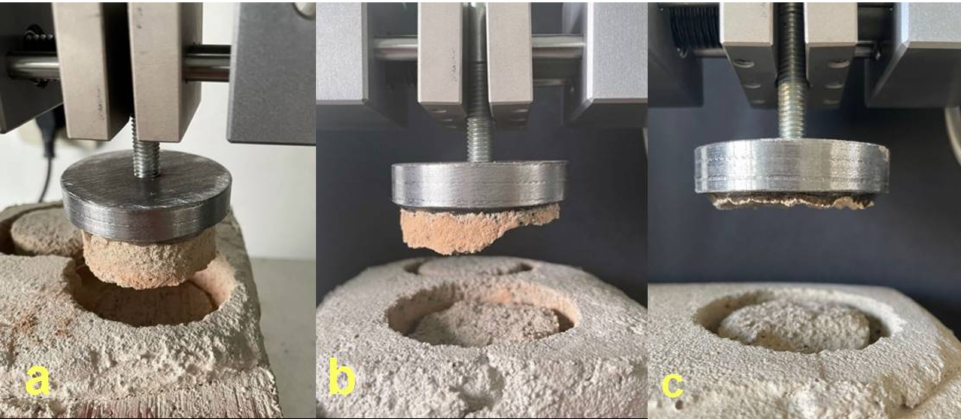
Figure 4. Types of fractures obtained during the adhesion test. ( a ) Fracture at the interface between the mortar and the brick; ( b ) Fracture inside the mortar layer; ( c ) Fracture at the interface between the mortar and the adhesive.